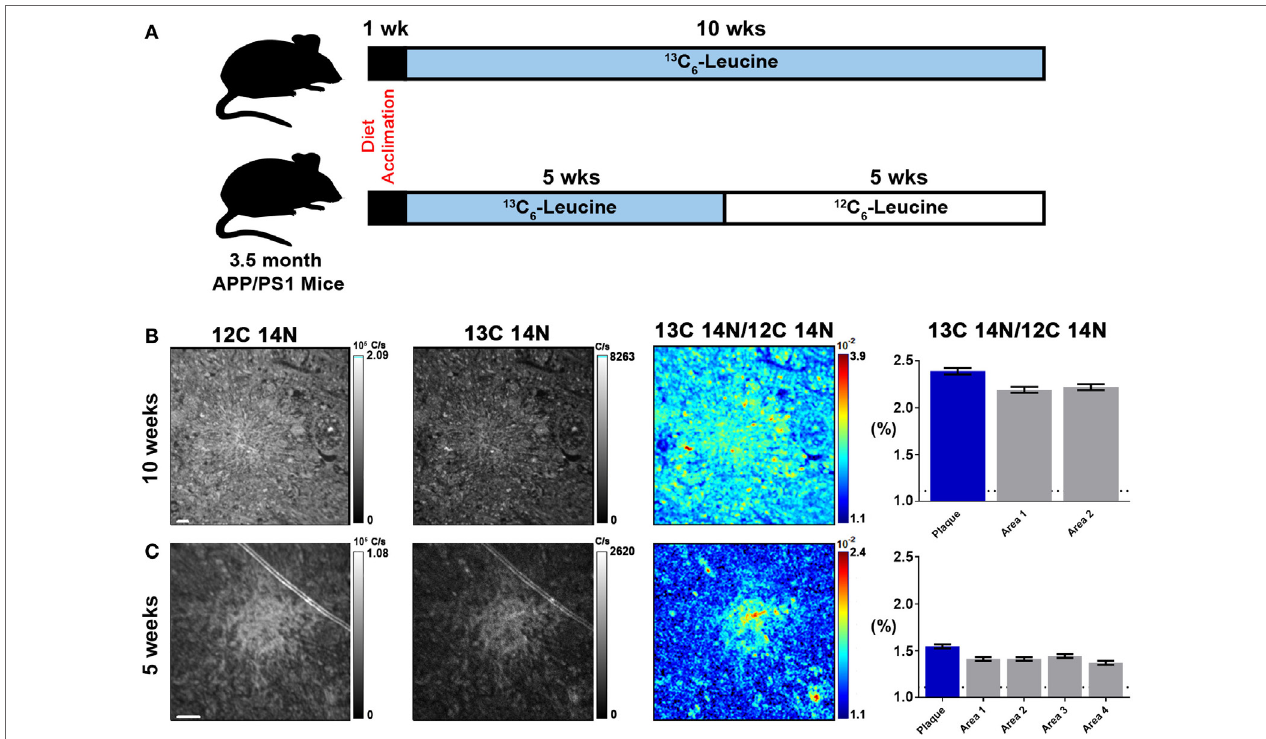
FigUre 2 | Stable isotope incorporation within plaques of APP/PS1 mouse model of Alzheimer’s disease. (a) Labeling scheme to determine the feasibility of detecting in vivo incorporation of stable isotope 13 C in native A β plaques. (B,c) From left to right, 12 C 14 N ion map, 13 C 14 N ion map, 13 C 14 N/ 12 C 14 N ion map, and normalized 13 C 14 N/ 12 C 14 N ratios of 10-week and 5-week labeled APP/PS1 mice, respectively (35 × 35 μ m images; see, Figure S4 in Supplementary Material, for region-of-interest (ROI) outlines based on plaque morphology and areas around the plaque defined such they do not overlap with plaque ROIs). Error bars indicate ± SD in quadrature of the SD of the average ratios measured for non-labeled cells (0%) and the Poisson errors of the feature itself (Equation 5 in Supplementary Material). Dashed horizontal line represents natural abundance of 13 C (1.1%). Scale bar , 2 µm.